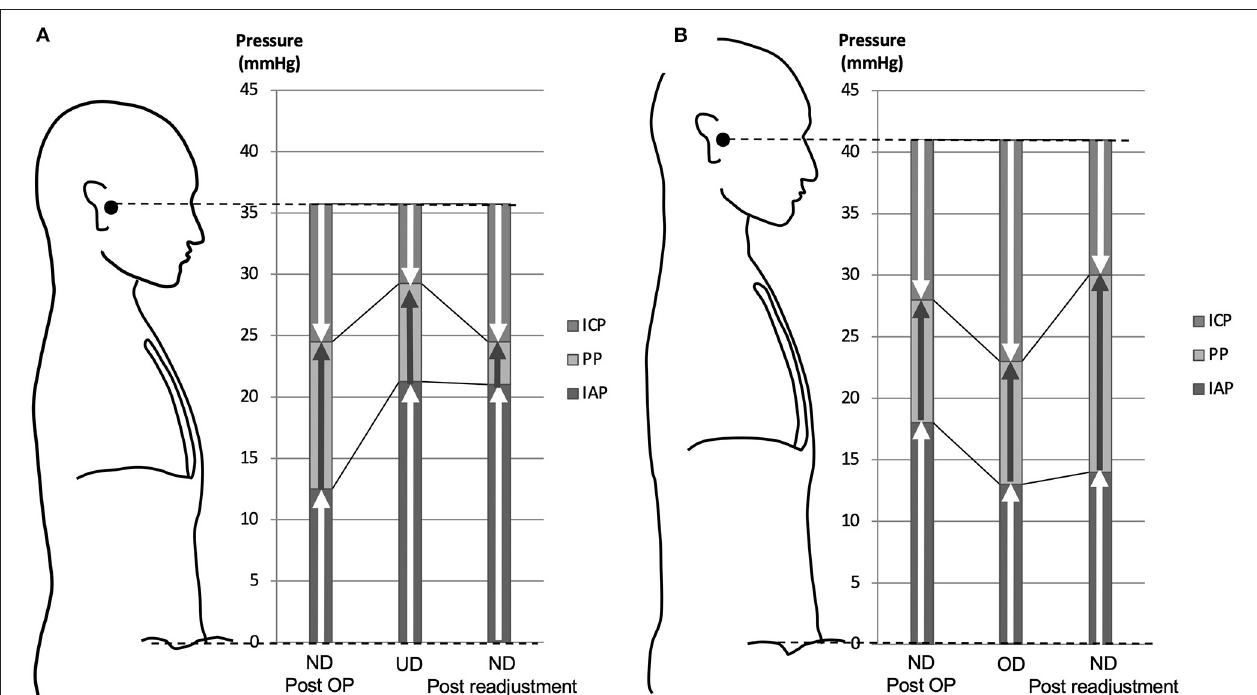
FIGURE 3 | Pressure diagram of underdrainage type WAIST (A) and overdrainage type WAIST (B) . (A) With an average weight gain of 6.8kg, the IAP increased by 8.8mm Hg and the ICP increased by 4.8mm Hg by linking to the IAP. As a result, the ICP is − 6.5mm Hg to the external auditory meatus. This ICP value is greater than the target range of − 8 to − 13mm Hg for ICP, which is the underdrainage range. Lowering the valve pressure by 4.4mm Hg, equivalent to 60mm H 2 O, reduced the shunt PP, resulting in an immediate recovery of ICP to − 11.3mm Hg, within the target range. (B) A 10-kg weight loss reduced IAP by 5.0mm Hg and ICP by 5.0mm Hg by linking to IAP. As a result, ICP is − 18mm Hg with reference to the external auditory meatus. This ICP value is lower than the ICP target range of − 8 to − 13mm Hg, which is in the overdrainage range. The shunt PP was increased by lowering the valve pressure to 5.1mm Hg, equivalent to 70mm H 2 O, and as a result, the ICP was restored to − 11.0mm Hg, within the target range. ND, normal drainage; UD, underdrainage; OD, overdrainage.